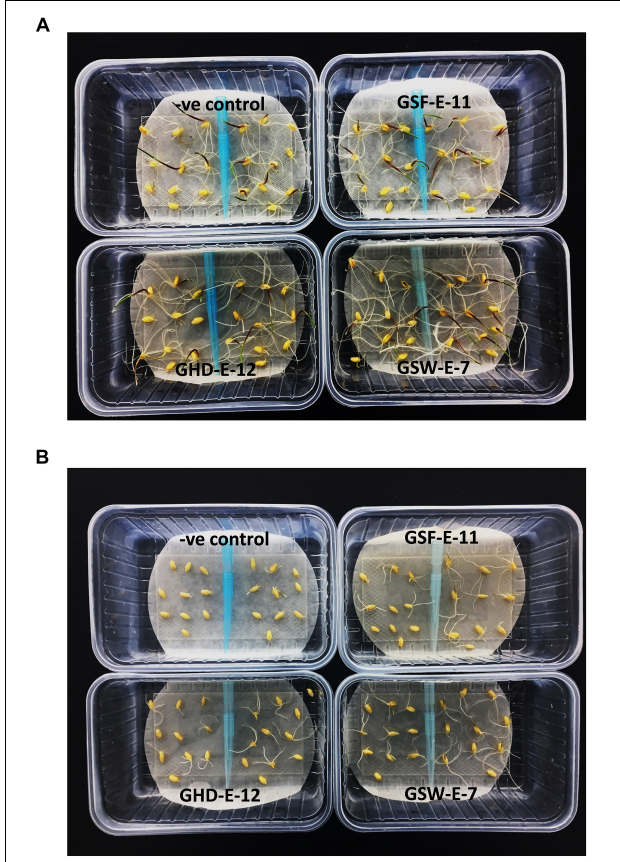
FIGURE 5 | Effect of inoculation with three PGPR bacterial strains, GHD-E-12, GSF-E-11 and GSW-E-7, on the germination of two durum wheat [right: Line 5004 ( NAX2 ); left: Tamaroi] after 5 days of culture. (A) Non-saline conditions. (B) 160 mM